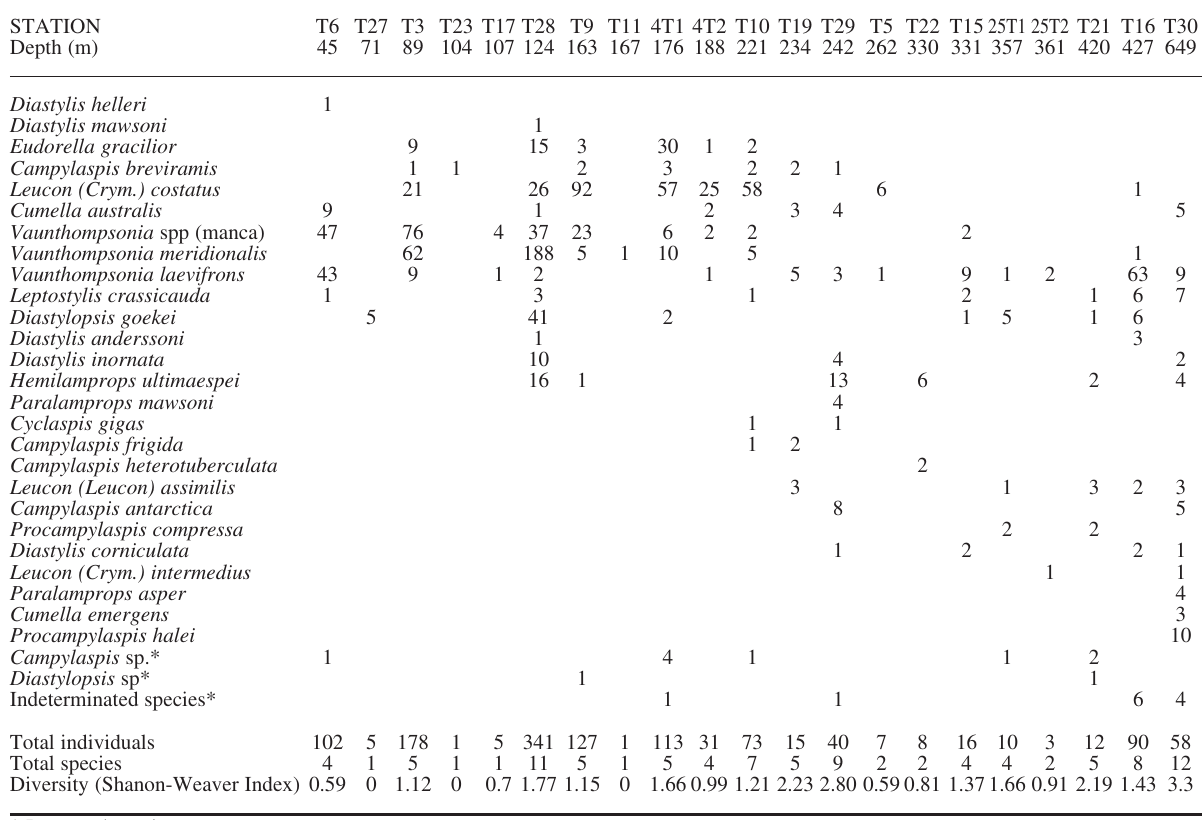
T ABLE 2. – Total abundance (N